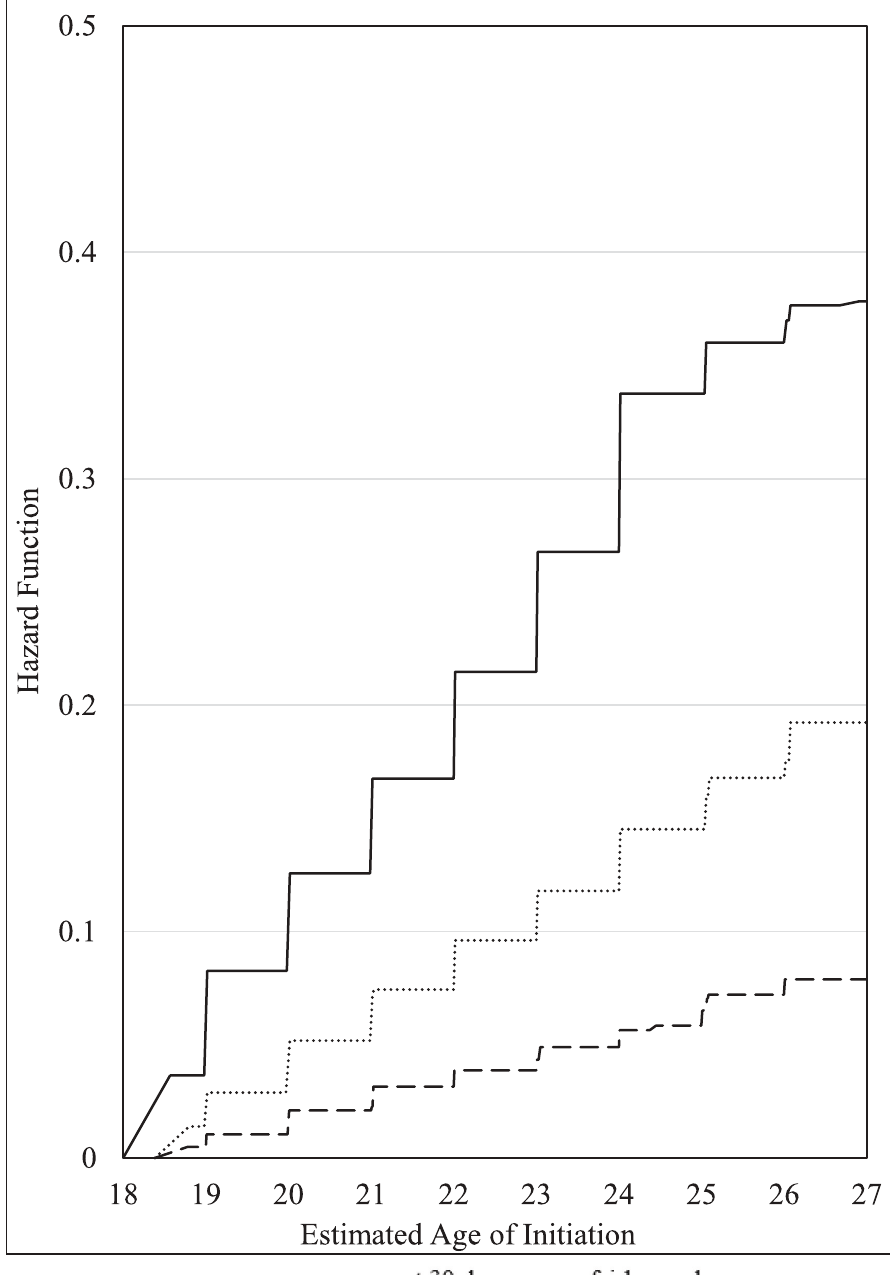
Fig 1. Estimated age of e-cigarette initiation in PATH young